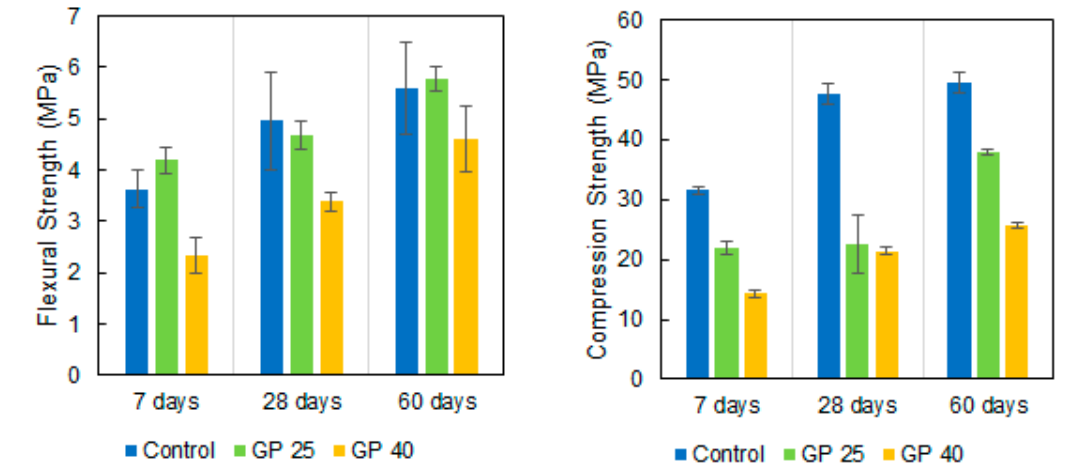
Figure 7. Flexural ( left ) and compression strength ( right ) values of the mortar mixes with different cement replacement rates with GP (average and standard deviation).